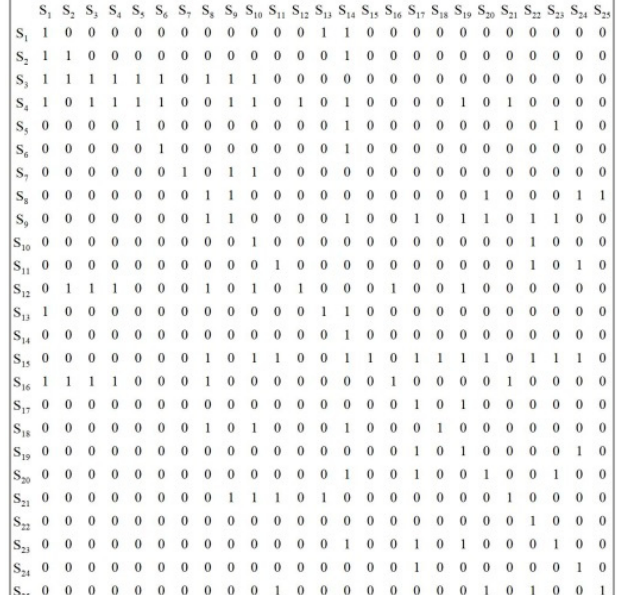
Figure 2. Adjacency matrix A.